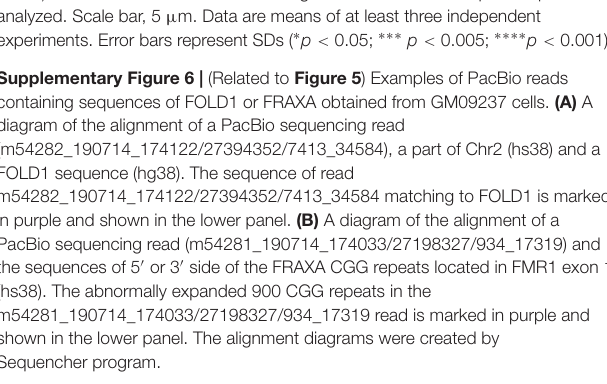
Supplementary Table 1 | (Related to Figure 1 ) An excel file of the genomic information of all of the AT-, or CG- rich repeats (period ranging from 1 to 14 bp) in human genome database, and the genomic information of AT-, or CG- rich trinucleotide repeats that have more than 50 copies in human genome database.